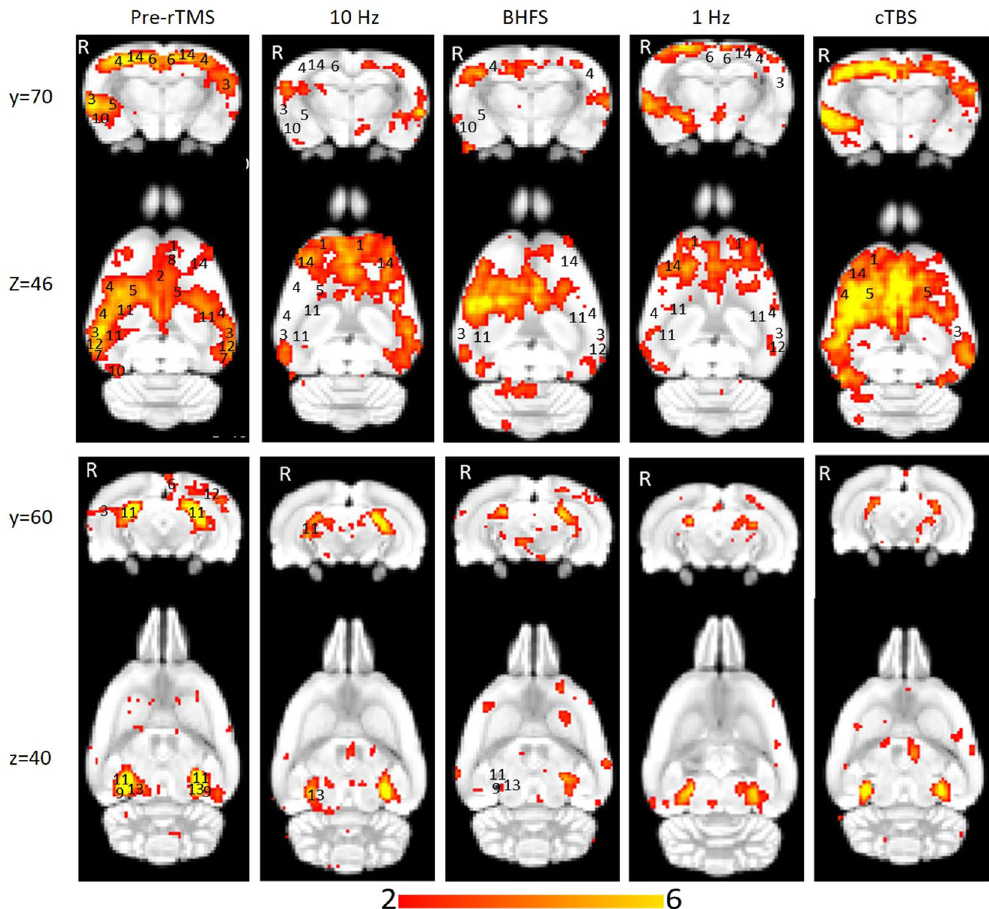
Figure 6. Homologous group-ICA components showing synchronised resting-state neuronal activity of isoflurane-anaesthetized rats before and after LI-rTMS at four frequencies: 10 Hz, BHFS, 1 Hz and cTBS. The post-stimulation colour-coded z-maps were derived from group-ICA on six animals and were overlaid on the Sprague Dawley brain template (down-sampled by a factor of eight). Coronal and axial slices for two representative ICA components are shown before (left) and after (right) stimulation at each of the four LI-rTMS protocols. A higher z-score (yellow) represents a higher correlation between the time course of that voxel and the mean time course of this component. Significant clusters within the components include various brain regions: 1, orbital cortex; 2, cingulate cortex; 3, auditory cortex; 4, somatosensory cortex; 5, striatum/caudate putamen; 6, retrosplenial cortex; 7, temporal association cortex; 8, prelimbic cortex; 9, parasubiculum; 10, entorhinal cortex; 11, hippocampus; 12, visual cortex; 13, inferior colliculus; 14, motor cortex. R denotes right hemisphere. x, y, z refer to the coordinates in standard Sprague Dawley template space. Colour bar indicates z-scores (thresholded at z > 2, uncorrected p-value < 0.0455 for a two-tailed